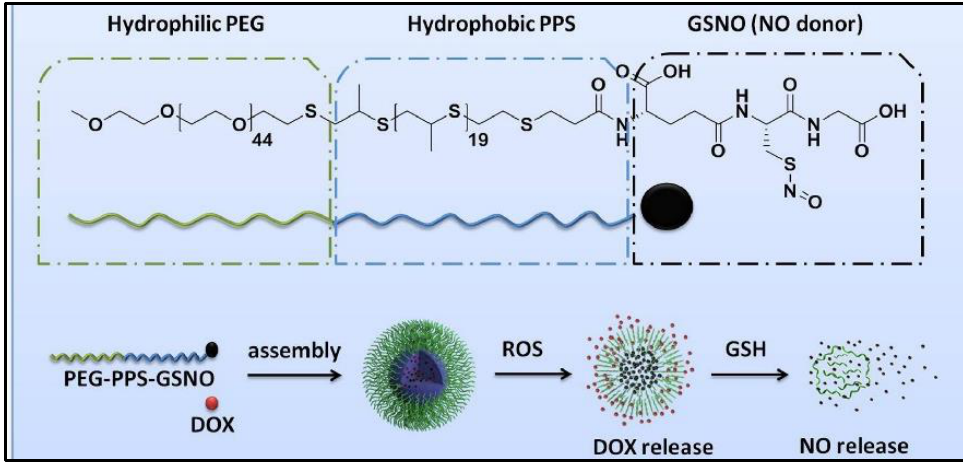
Figure 9. Schematic of fabrication of GSNO/pSiNPs [70].